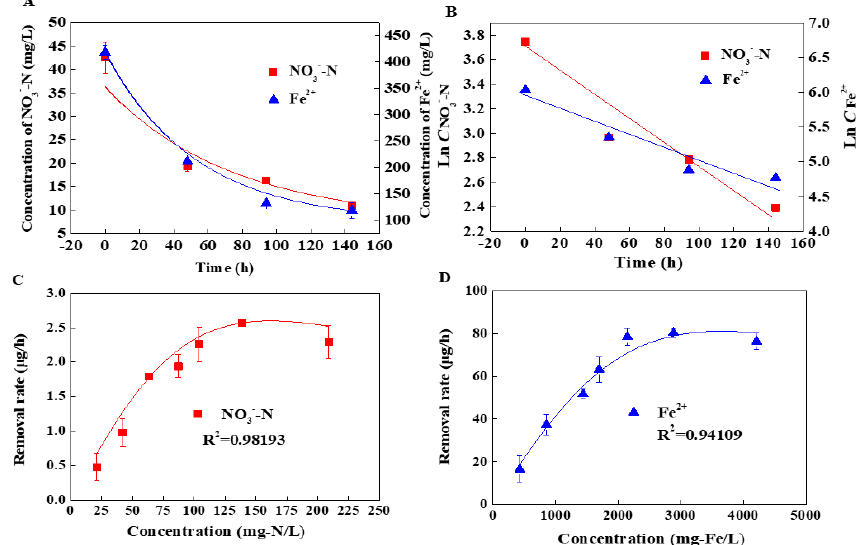
Figure 1. Nitrate reduction and Fe(II) oxidation activities of Shewanella sp. strain F1. ( A ) The decrease of nitrate and Fe(II) concentration along with cultivation time. ( B ) The first − order kinetics fitting of nitrate reduction and Fe(II) oxidation rate by strain F1. ( C ) The nitrate reduction rate by strain F1 at different nitrate concentrations. ( D ) The Fe(II) oxidation rate by strain F1 at different Fe(II) concentrations.